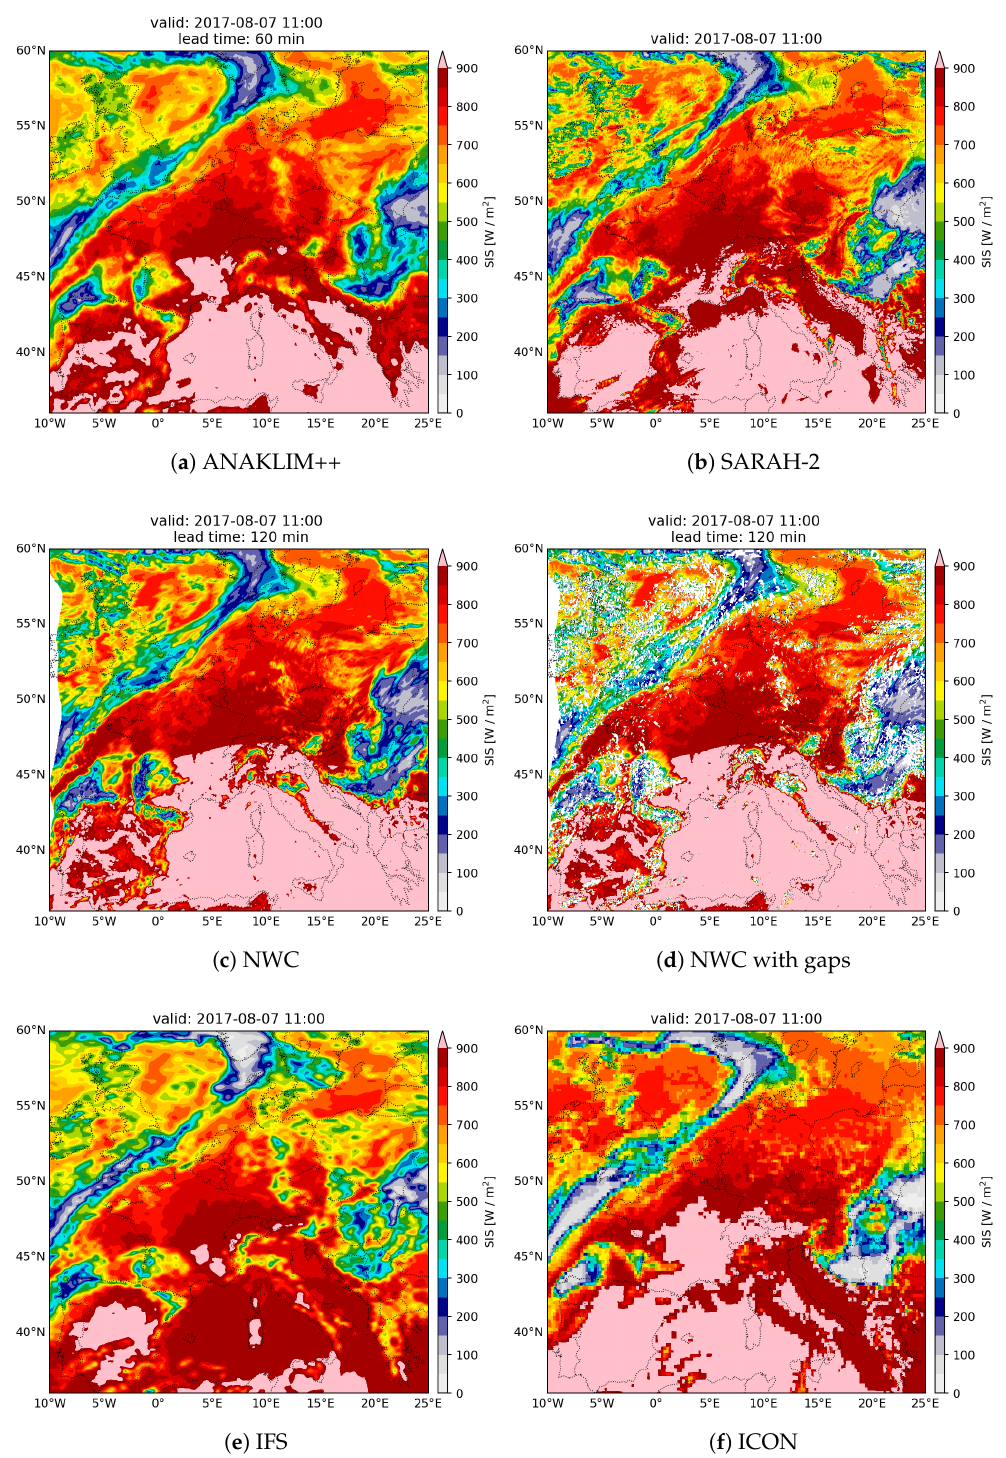
Figure 2. Hourly averaged SIS (surface incoming shortwave radiation) of ( a ) the blending with ANAKLIM++, ( b ) SARAH-2 (surface radiation data set–Heliosat), ( c ) NWC, ( d ) NWC with data gaps, ( e ) IFS and ( f ) ICON for 2017-08-07 11 UTC,